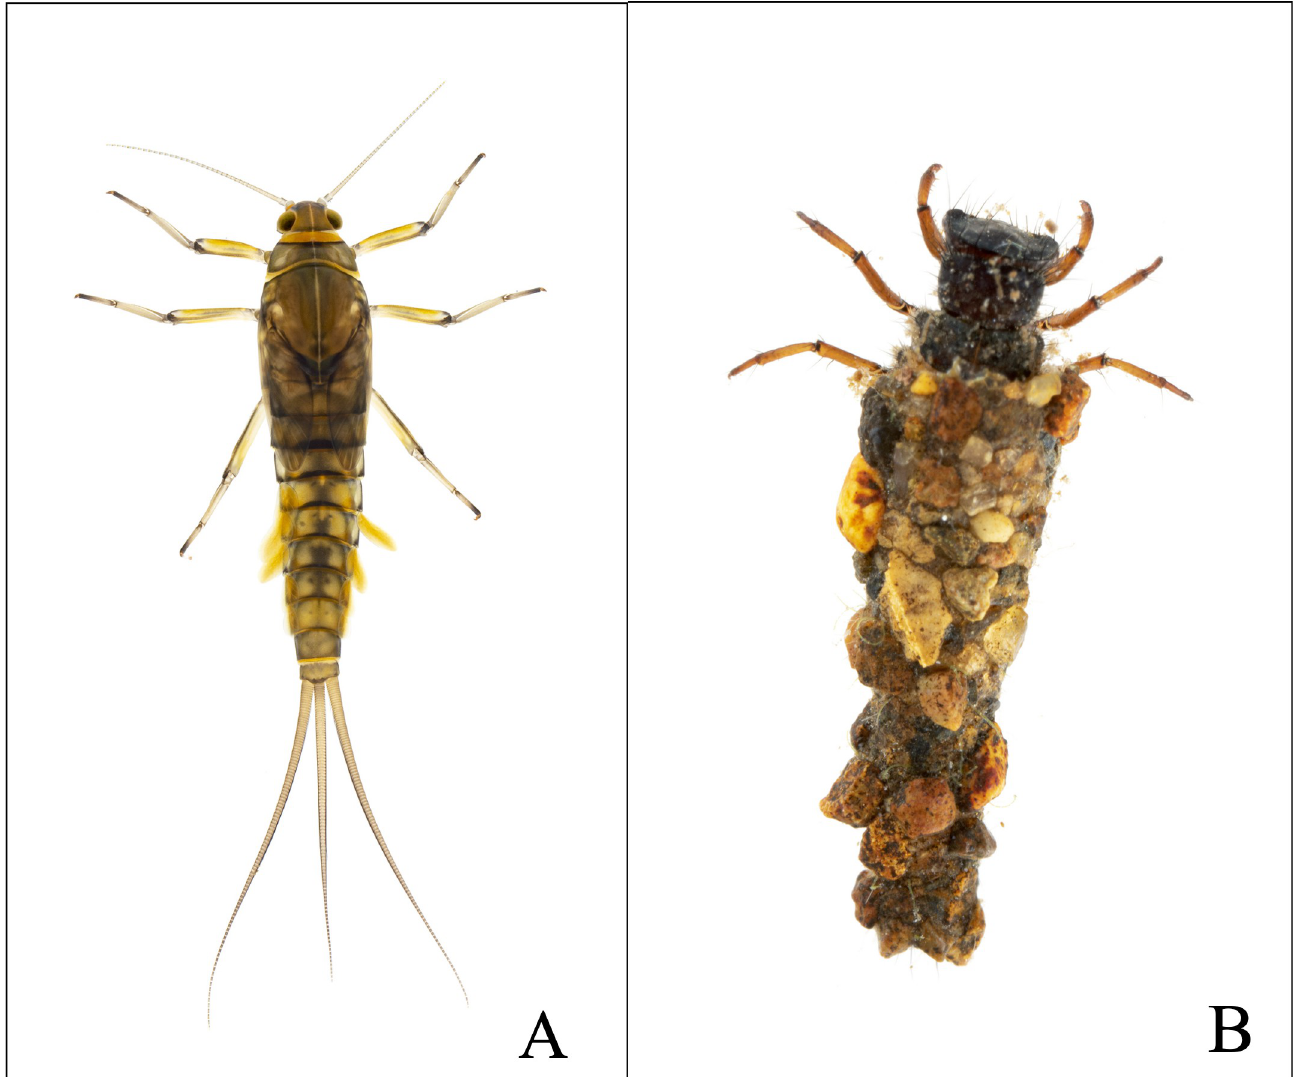
Fig 4. Larvae of aquatic insect species. ( A ) Mayfly larvae, Andesiops peruvianus (Ulmer, 1920). ( B ) Caddisfly larvae, Anomalocosmoecus illiesi (Marlier, 1962). Reprinted from [www.ex-situphotography.com/es/proyectos-publicacio´nes/proyectos-publicaciones] under a CC BY license, with permission from [Vieira,